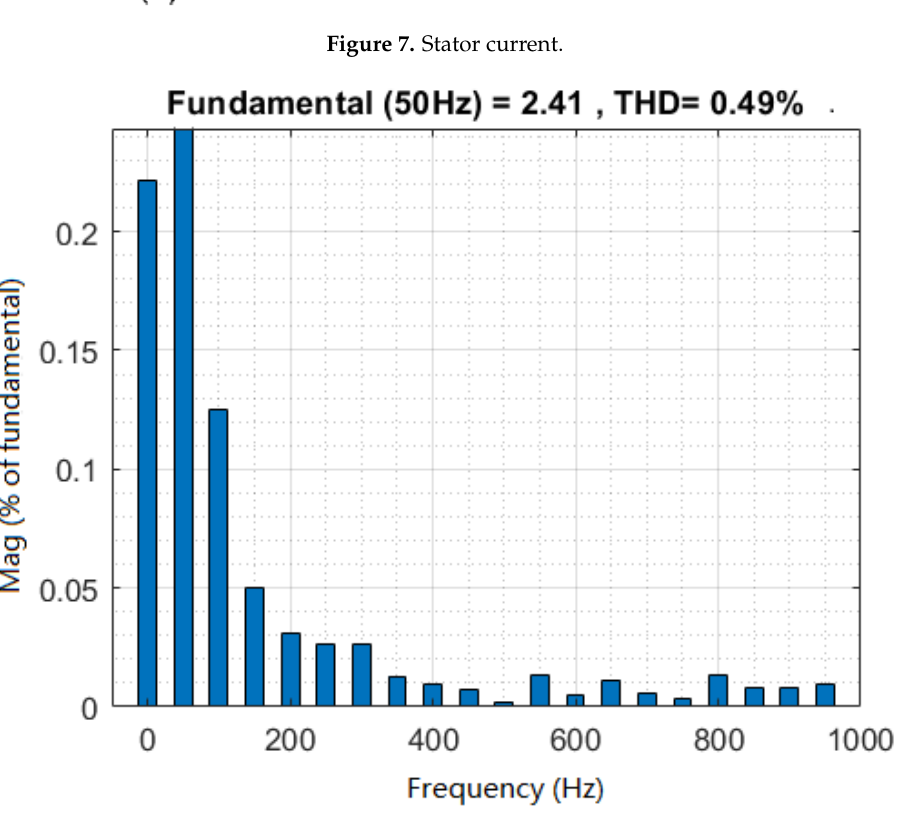
Figure 8. Figure 8. THD.